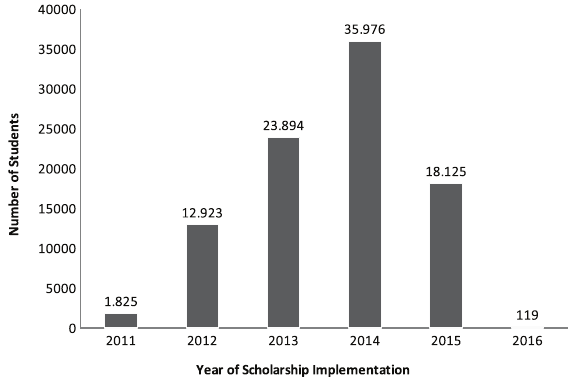
Figure 4 - Number of SwB scholarships implemented per year (Capes and